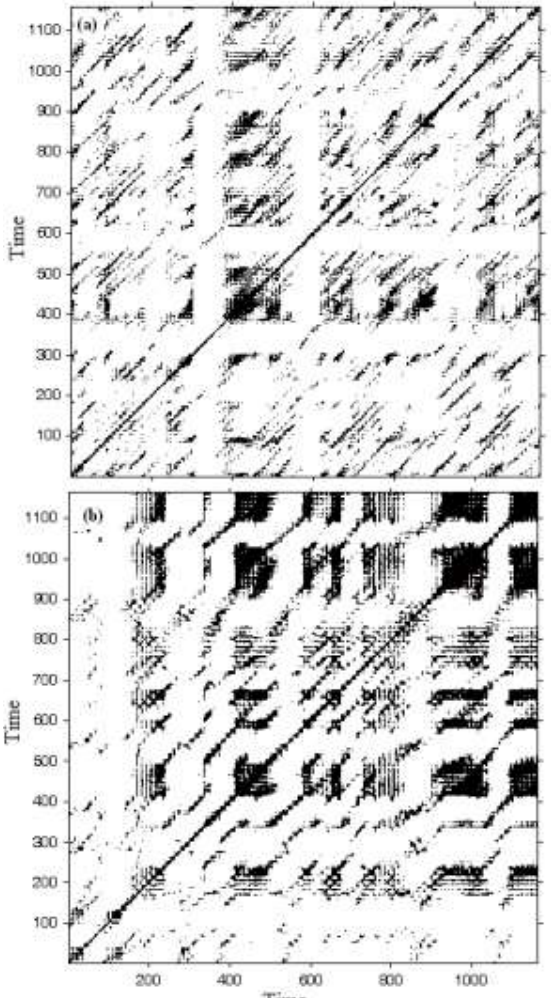
Figure 11. (a) RP of wind speed time series, (b) RP of wind power time